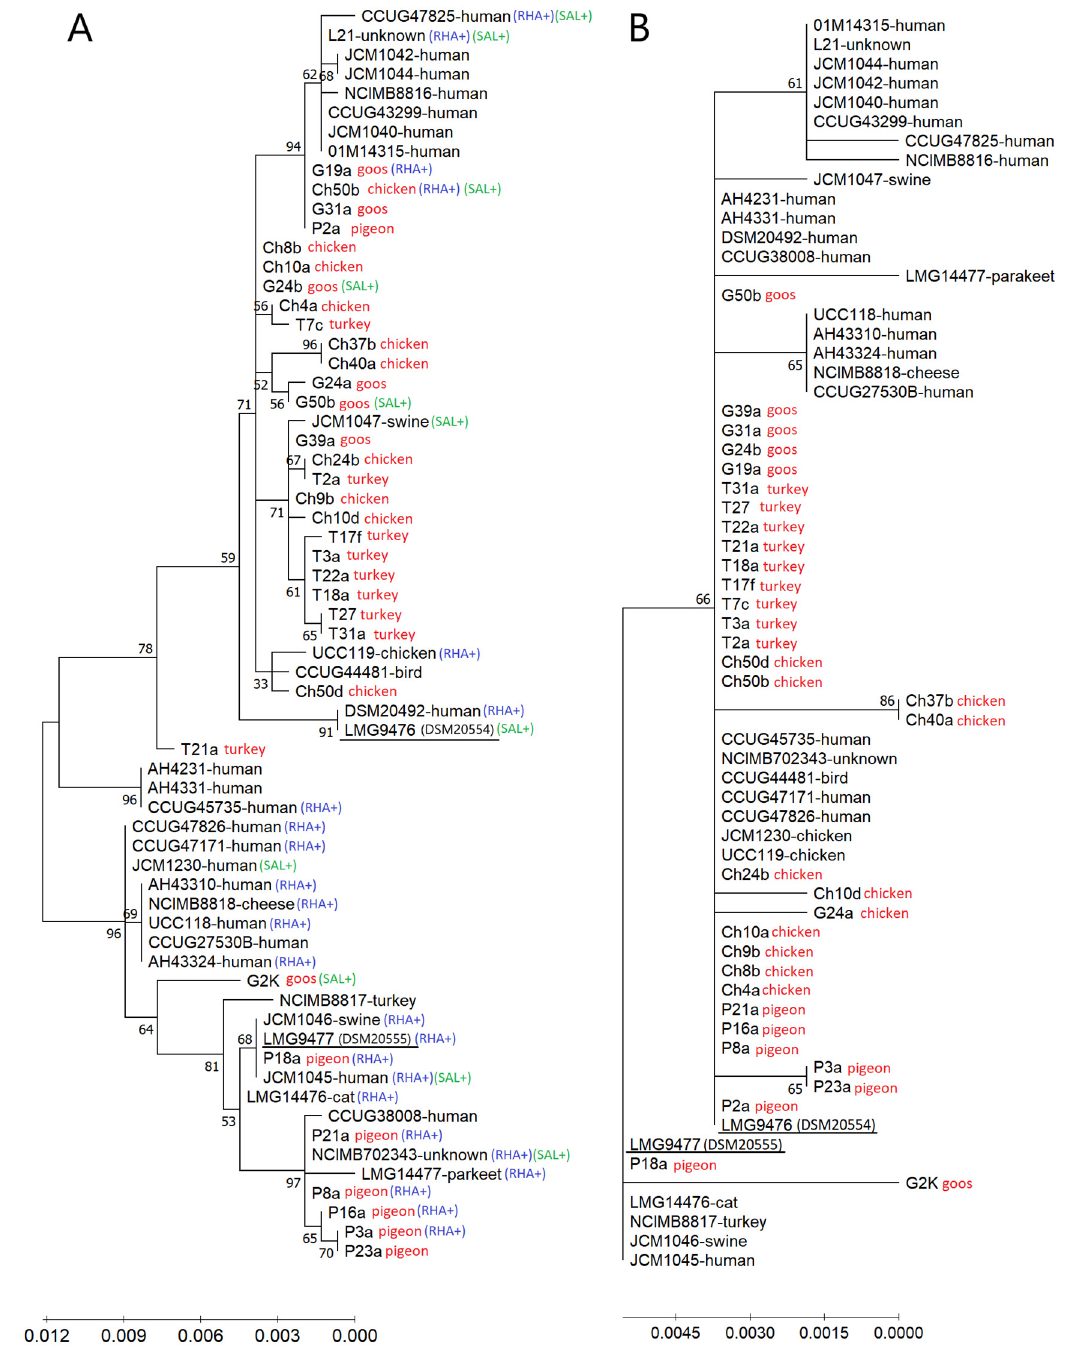
Figure 5. ( A ) Phylogenetic trees based on the groEL gene sequences of 33 wild-type avian L. salivarius strains tested in this study and 30 L. salivarius strains (mainly of human origin) previously described by Li et al. [18] built by the maximum likelihood method. The percentage of replicate trees in which the associated taxa were clustered together in the bootstrap test (500 replicates) is shown next to the branches. Scale bars show genetic distance; RHA+ and SAL+ indicate the ability of strains to utilize rhamnose and salicin, respectively. ( B ) Dendrogram showing the similarity among the predicted amino acid sequences of the GroEL chaperonin built by the maximum likelihood method.